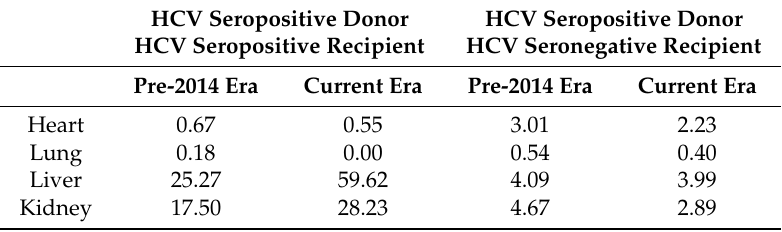
Table 2. Comparison of average annual rates of transplantation (annual number of transplants per 1000 transplants) of organs from HCV seropositive donors by recipient HCV serostatus in the pre-2014 and current eras. HCV Seropositive Donor HCV Seropositive Donor HCV Seropositive Recipient HCV Seronegative Recipient Pre-2014 Era Current Era Pre-2014 Era Current